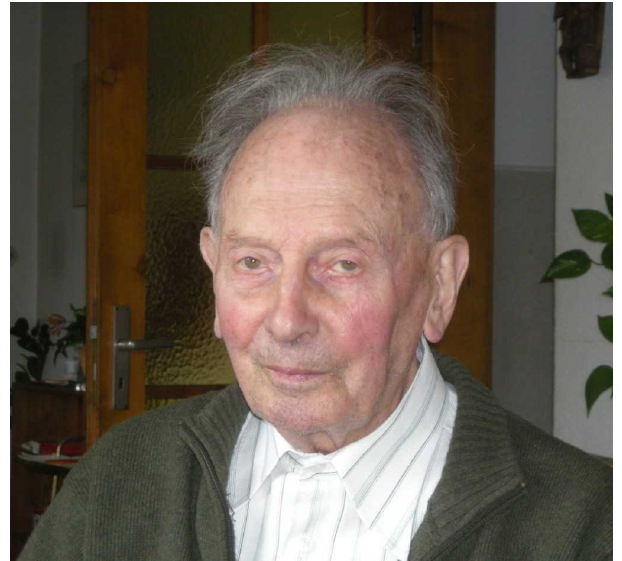
Figure 1. Karl Rawer in